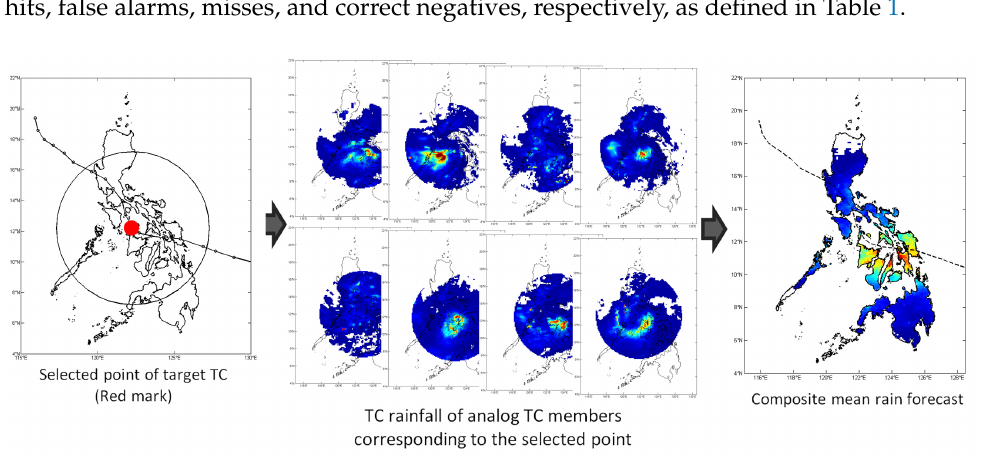
Figure 1. Methodological framework of the analog TC forecasting. (Solid dotted-line/dashed-line is the target TC track, and the circle is the 5° extent from the selected TC center. Color scale is the same as Figures 2 and